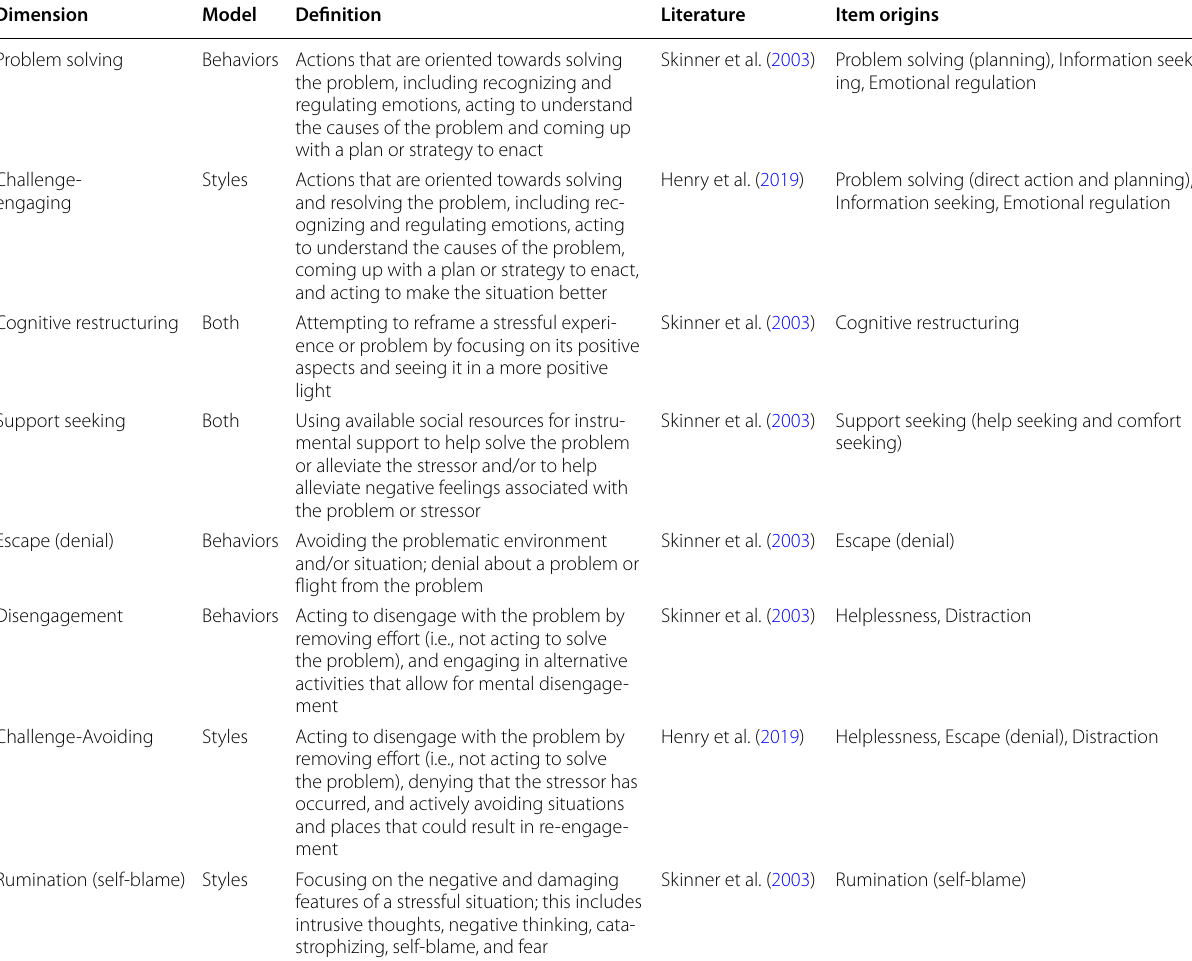
Table 6 Definitions of proposed dimensions